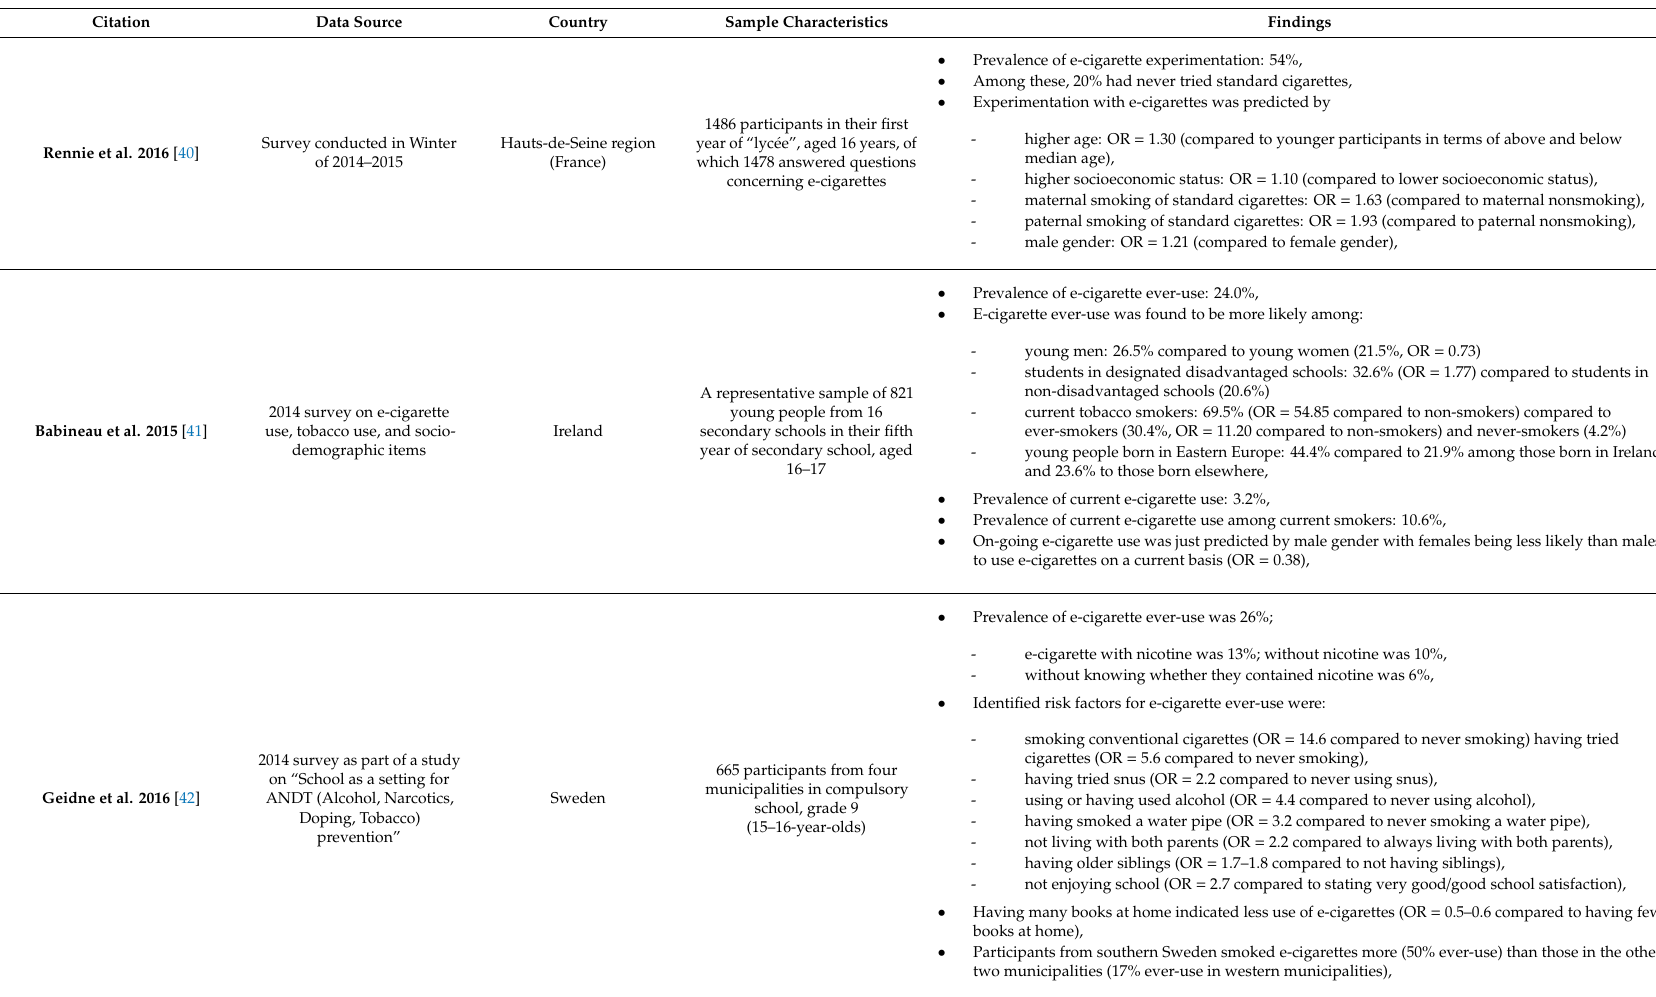
maternal smoking of standard cigarettes: OR = 1.63 (compared to maternal nonsmoking), - paternal smoking of standard cigarettes: OR = 1.93 (compared to paternal nonsmoking), - male gender: OR = 1.21 (compared to female